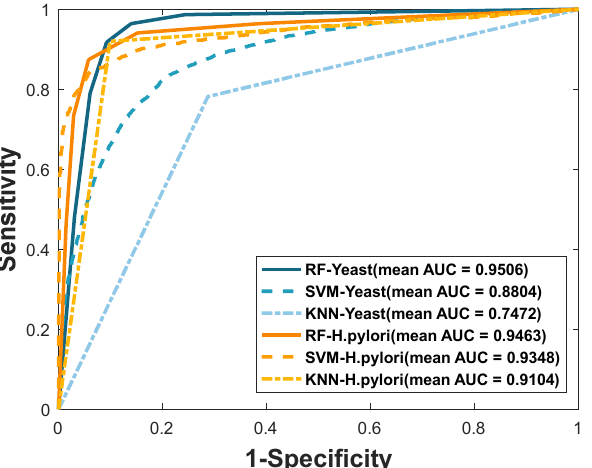
Figure 6. Comparison of ROC curves for different classifiers of RF, SVM, and KNN on two datasets: Yeast and H. pylori .